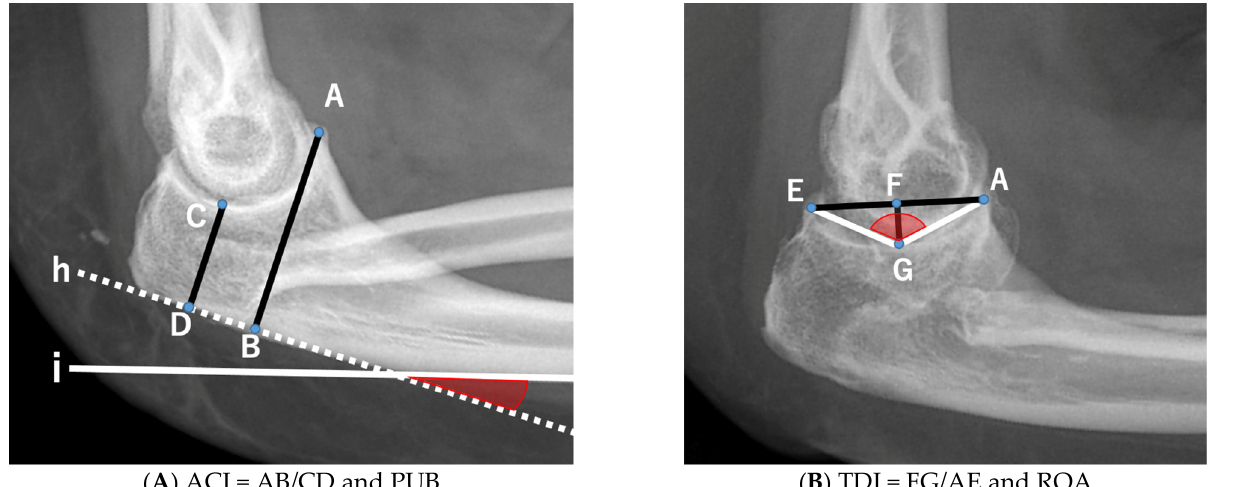
Figure 1. Index measurement of the elbow joint. A: tip of the coronoid process, AB: linear distance between point A and the posterior olecranon line, CD: minimal proximal ulna trochlear height, E: tip of the olecranon process, F: midpoint of the segment from AE, G: deepest point of the trochlear notch (determined by the intersection of a line perpendicular to AE and passing through point G and the trochlear notch), h: posterior olecranon cortex line, i: posterior ulna cortex line. ( A ) Proximal Ulnar Bow (PUB) is determined by lines h and i. ( B ) Radiographic Opening Angle (ROA) is determined by lines AG and GE. ACI, Anterior Coverage Index; TDI, Trochlear Depth Index.